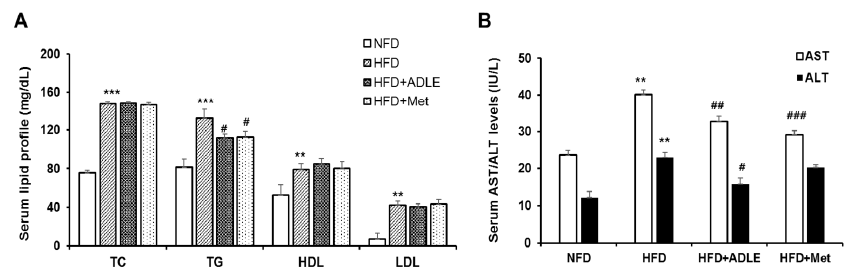
Figure 3. ADLE altered lipid profiles, AST, and ALT levels in serum of HFD-induced diabetic mice. Mice were treated as described in Figure 1. After 6 weeks of ADLE treatment, serum was collected, and ( A ) lipid profiles: total cholesterol (TC), triglyceride (TG), high-density lipoprotein (HDL), and low-density lipoprotein (LDL) and ( B ) aspartate aminotransferase (AST) and alanine aminotransferase (ALT) were measured by specific assay kits. The results are expressed as means ± SD ( n = 6–8). ** p < 0.01, *** p < 0.001 vs. NFD group. # p < 0.05, ## p < 0.01, and ### p < 0.001 vs. HFD group. NFD, normal-fat diet; HFD, high-fat diet; HFD + ADLE, high-fat diet + ADLE; HFD + Met, high-fat diet + Met.